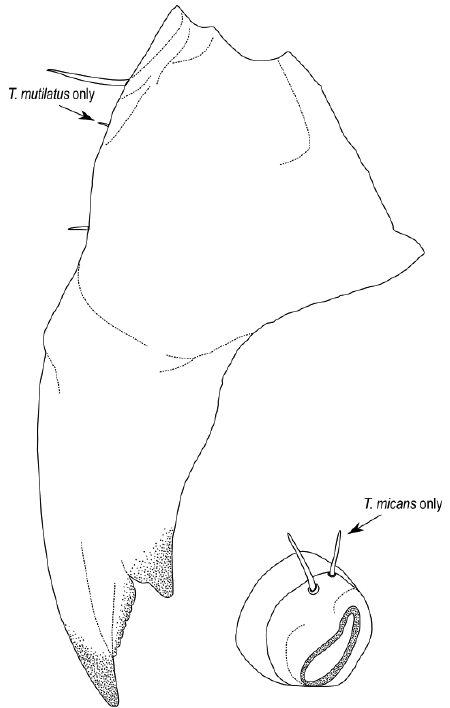
Figure 2. Right mandible in dorsal view and mesothoracic spiracle of mature Afrotropical Thanatophilus larvae. The arrows indicate species-specific diagnostic characteristics: T. micans has two ventrolateral man- dibular setae and one spiracular seta, while T. mutilatus has three ventrolateral mandibular setae and two spiracular